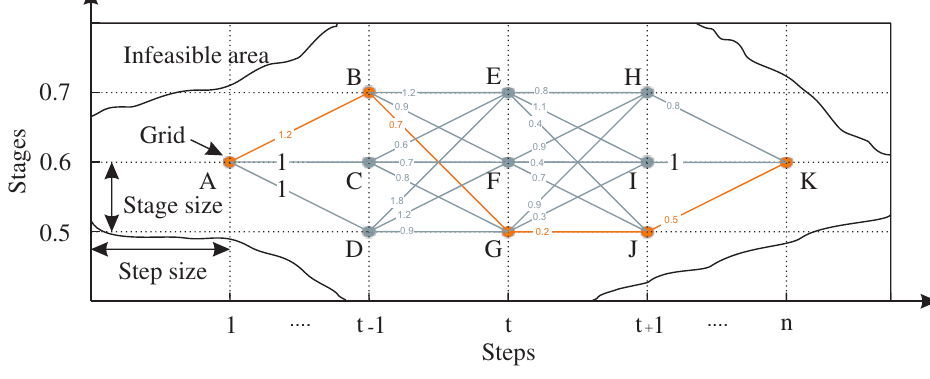
Figure 3. Dynamic programming